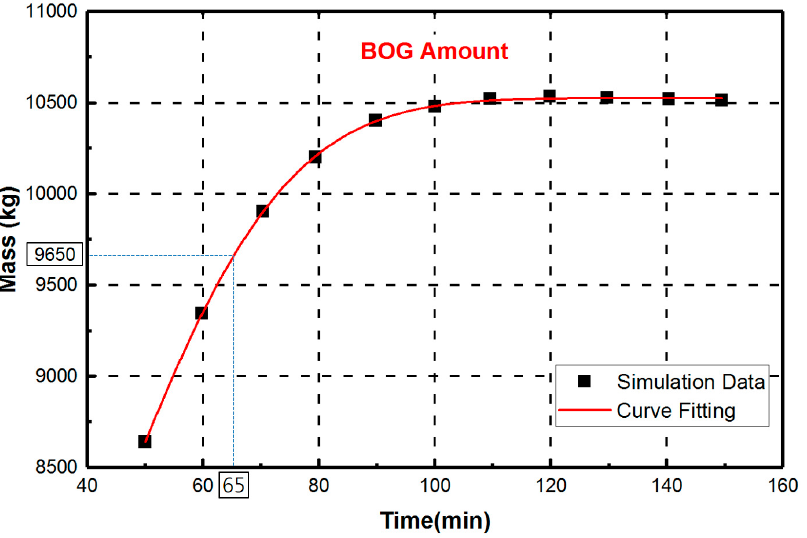
Figure 11. Mass of BOG generation amount and its curve fitting result.